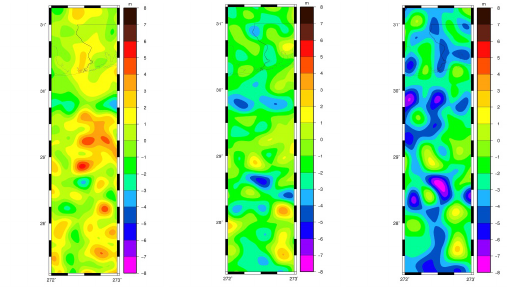
Figure 5. Residual gravity anomalies on the ground. From left to right: the residual gravity anomaly of FS(L), FS(M) and FS(H).